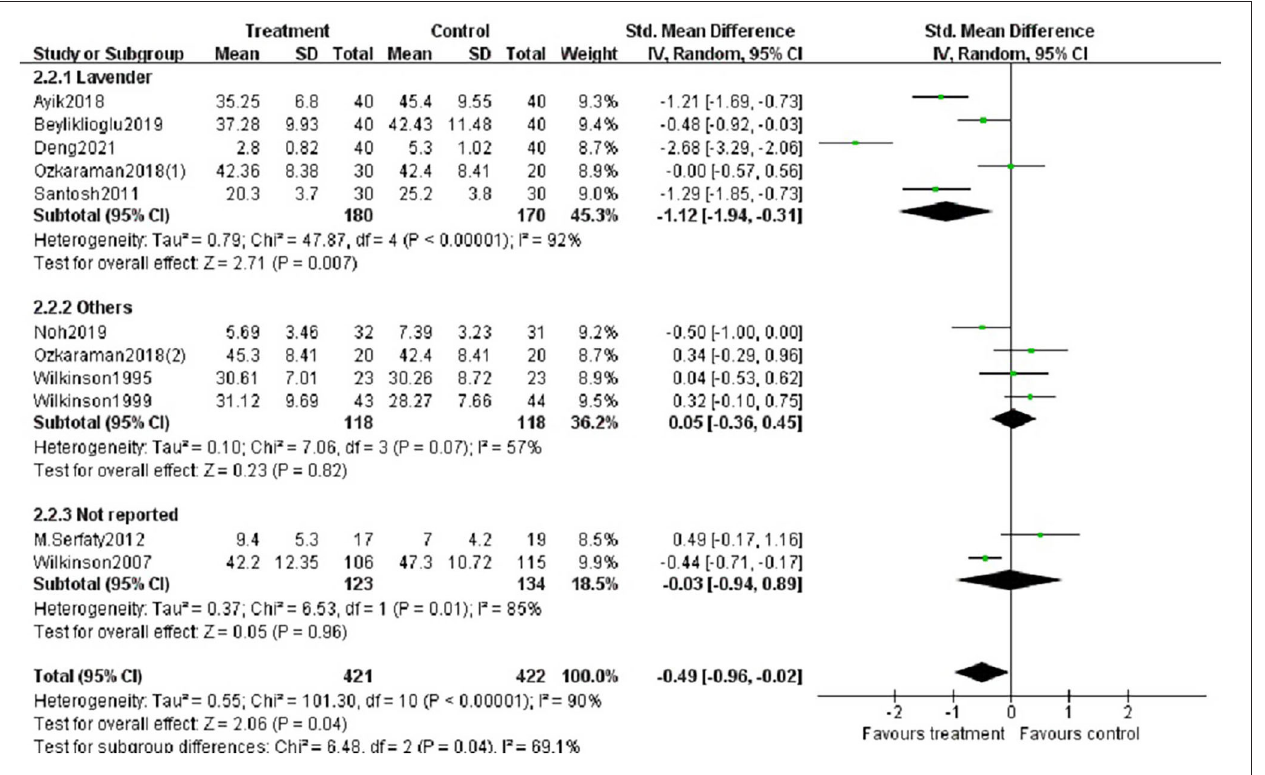
FIGURE 7 | Subgroup analysis according to the type of essential